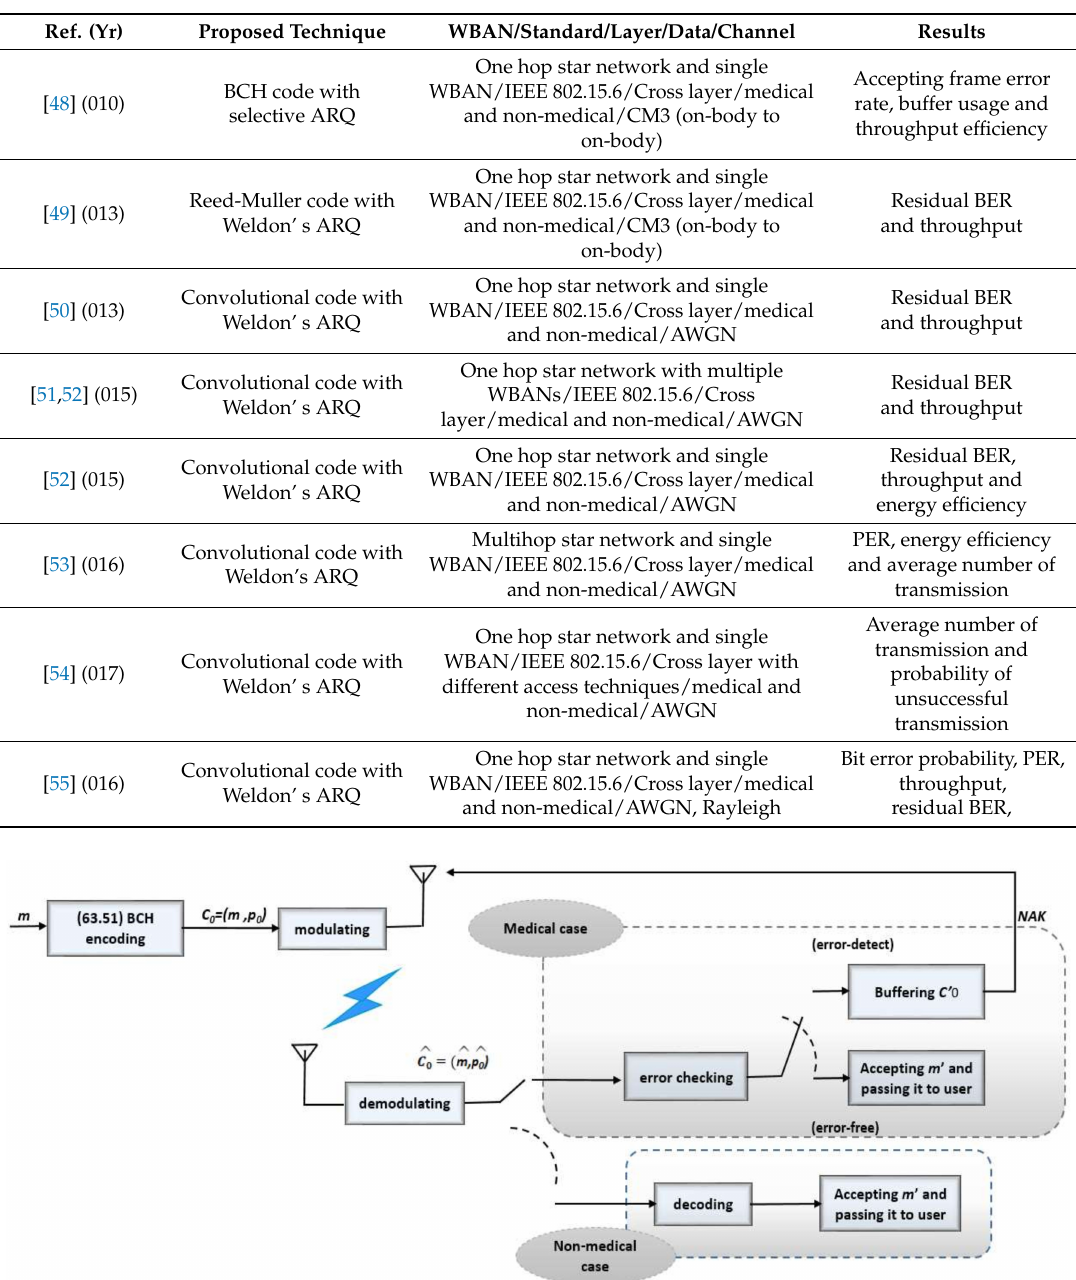
Table 7. A review of HARQ-II based ECS.